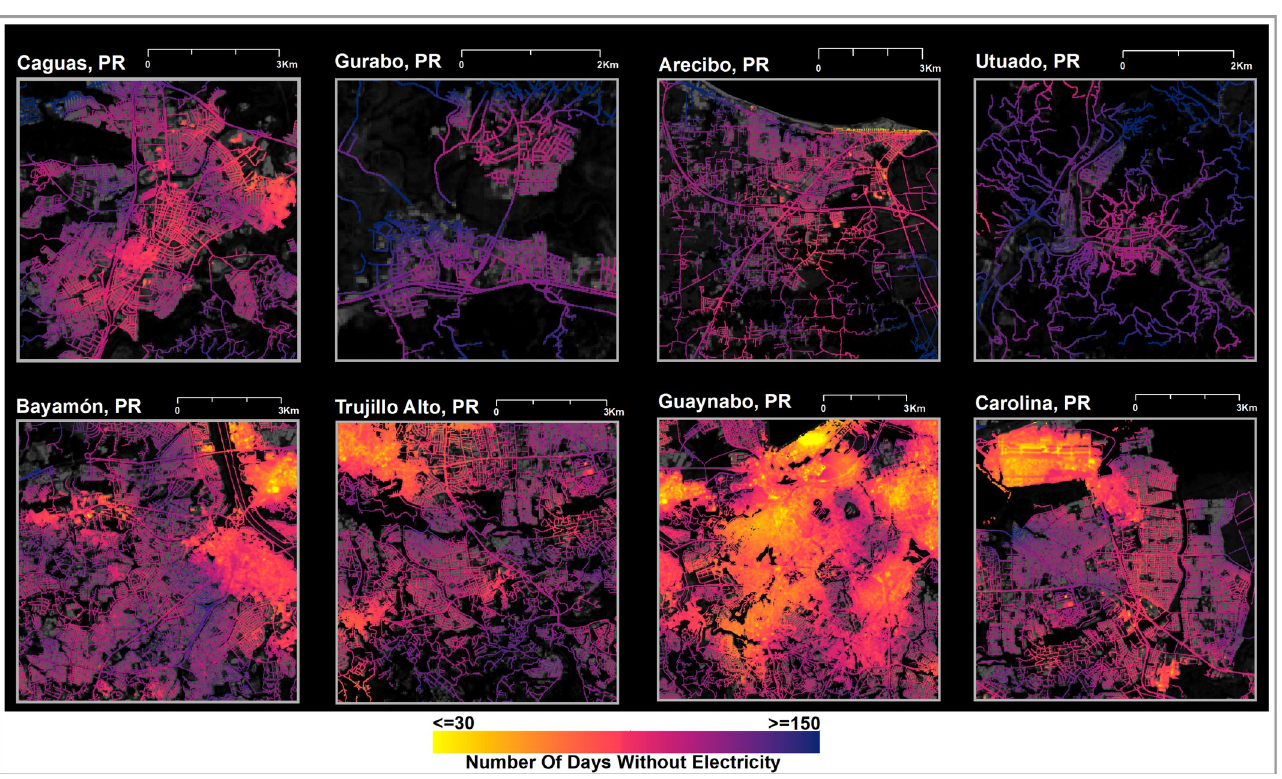
Fig 5. Progression of electricity recovery across a subset of Puerto Rico’s neighborhoods using NASA Black Marble high definition nighttime lights. (Top) Deficits in energy access were found between regional urban centers (e.g., Caguas and Arecibo) and adjacent rural towns (Gurabo and Utuado respectively). (Bottom) Fragmented patches of recovery demonstrate the significant variations in NDWE (between September 20, 2017 and March 20, 2018) within the San Juan metropolitan region.